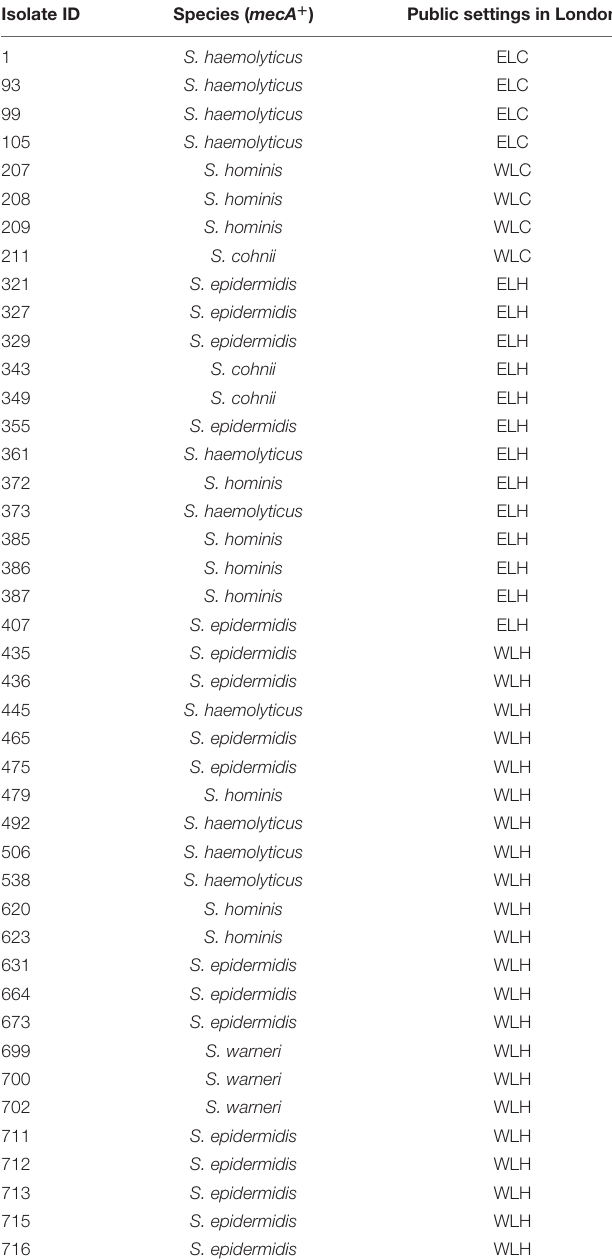
TABLE 1 | mecA + coagulase negative staphylococcal isolates recovered from East and West London public settings. Isolate ID Species ( mecA + )